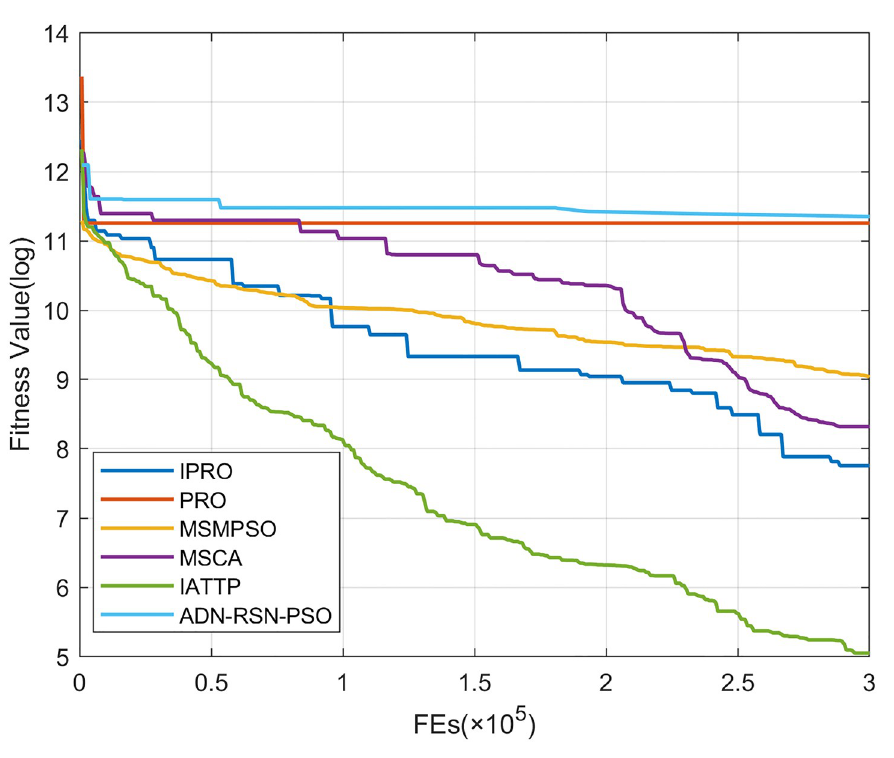
Fig 4. Convergence curves on F4.